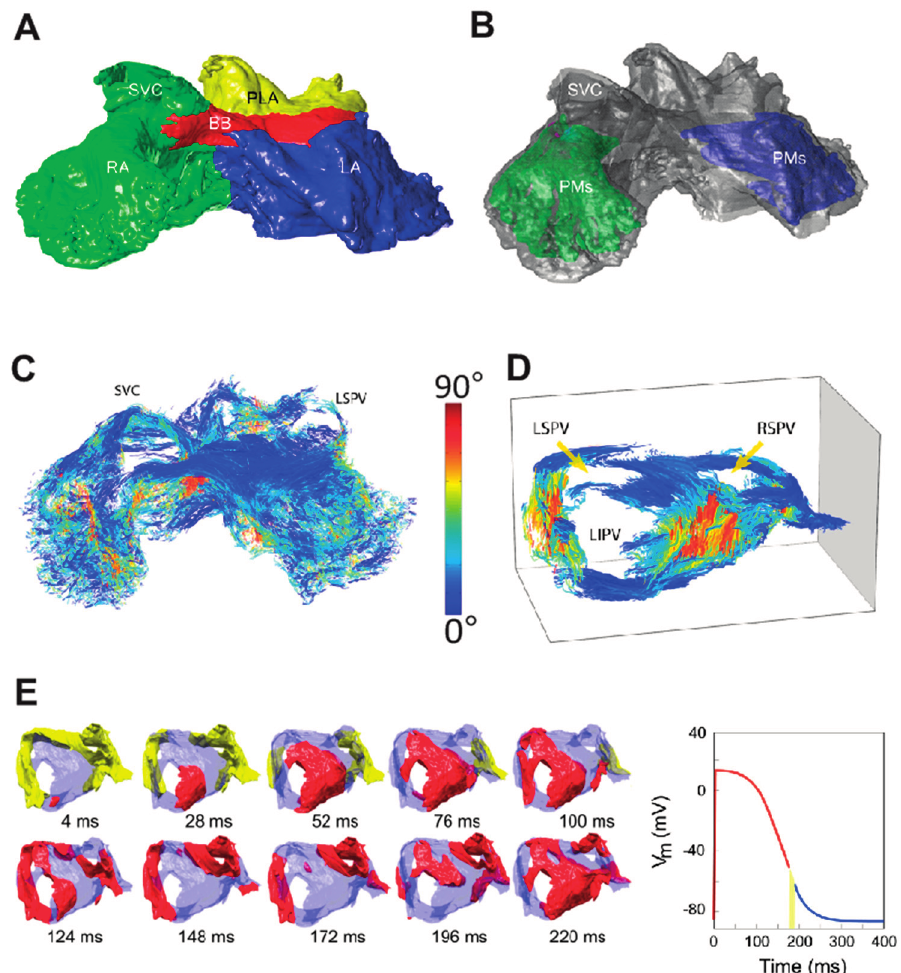
Figure 2. Auckland sheep atrial model [24,25]. ( A ) Epicardial surface view of sheep atria displayed from an anterior angle; ( B ) Pectinate muscle bundles (PMs) were highlighted under both atrial chambers; 3D fiber structure is displayed for the whole atria ( C ) and PLA ( D ) using a structure tensor approach; ( E ) The PLA regional computer model was employed to investigate the mechanisms behind electrical instability. SVC/IVC — Superior/inferior vena cava; BB — Bachmann’s bundle; R/LSPV — Right/left superior pulmonary veins; PLA — Posterior left atrium; R/LIPV — Right/left inferior pulmonary veins; RA /LA— Right/ left atrium. Reprinted from [24,25] with permission from Wolters Kluwer Health and Institute of Electrical Electronics Engineers,